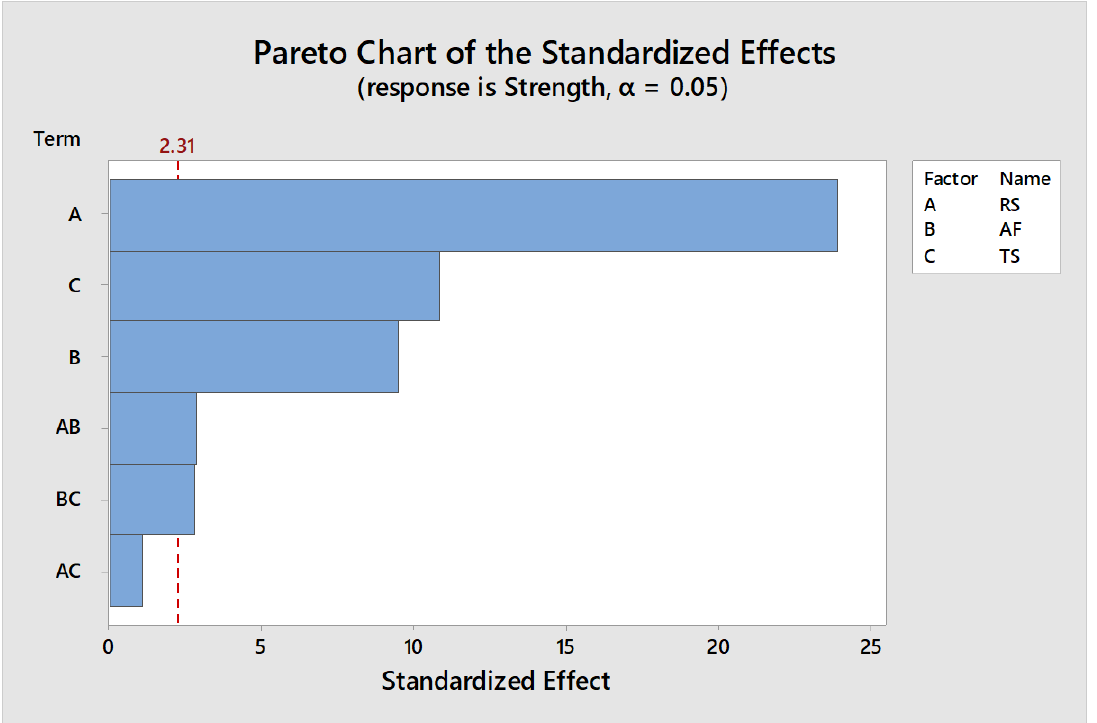
Figure 25. Pareto chart — strength.